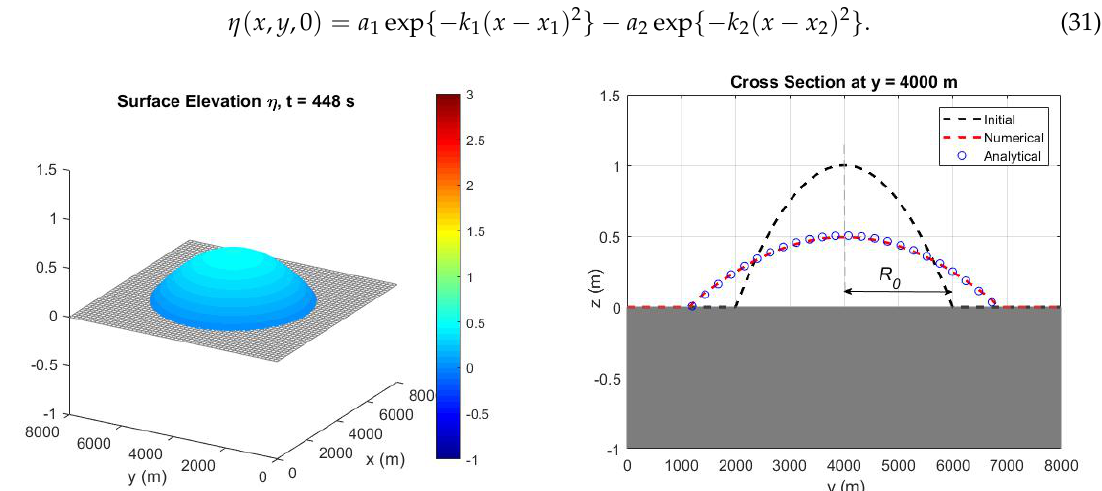
Figure 4. ( left ) Surface profile in the parabolic flood wave test case, ( right ) centerline surface at time t = T , at which the maximum wave height has reduced from 1 m to 0.5 m.